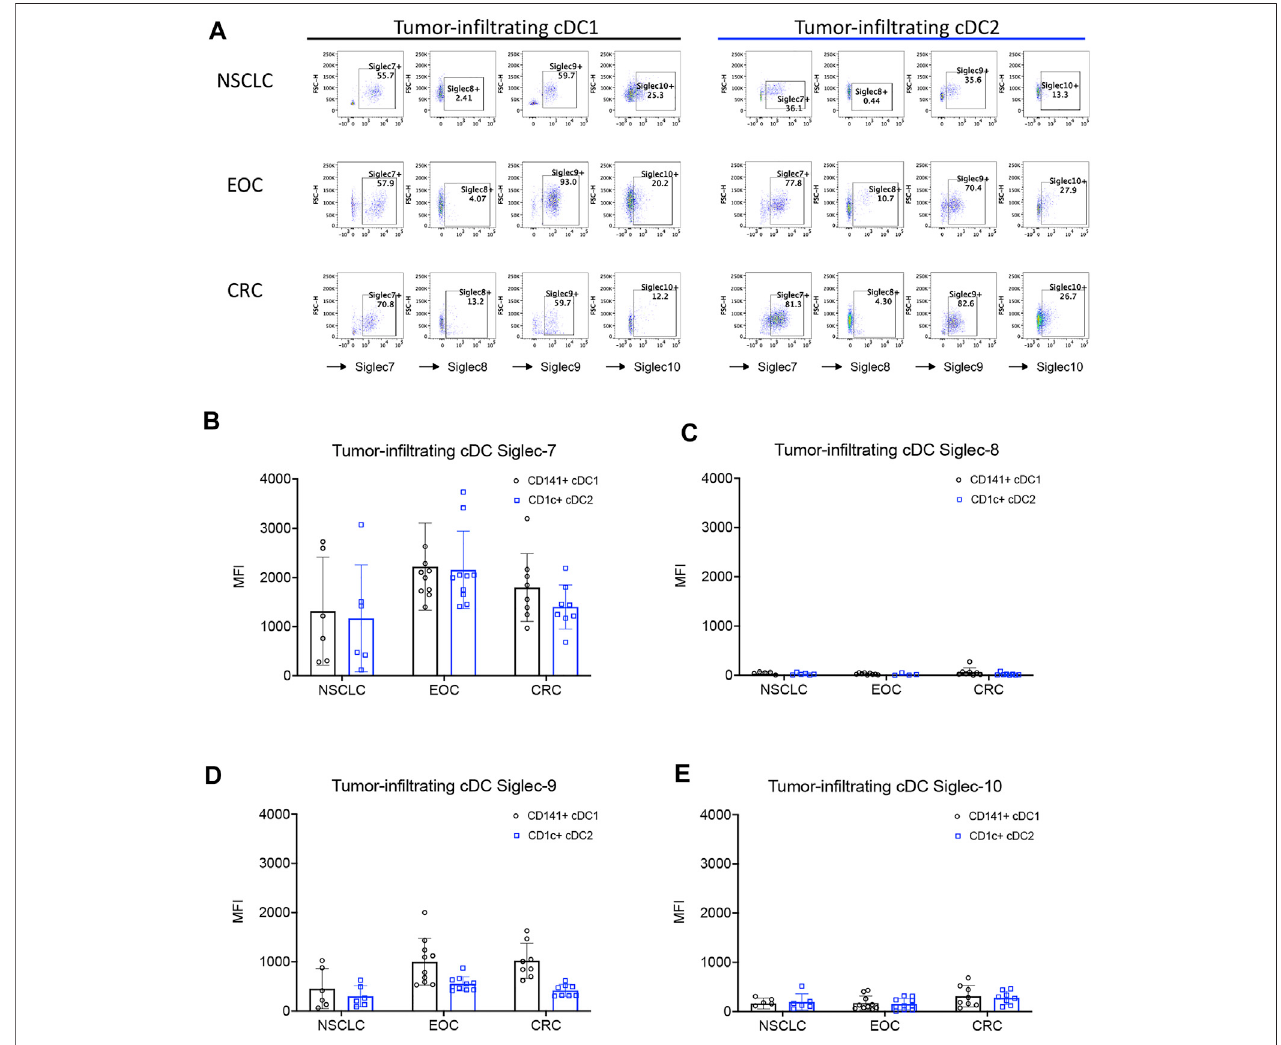
FIGURE 1 | Expression of inhibitory Siglecs on human tumor-in fi ltrating DCs. (A) Representative examples of Siglec receptor expression determined by fl ow cytometry on different cDC subsets from primary patient samples. (B – E) The expression levels of inhibitory Siglecs on DCs from primary tumor samples of patients with non-small cell lung cancer (NSCLC), epithelial ovarian cancer (EOC), and colorectal cancer (CRC). Data are presented as mean ± SD.